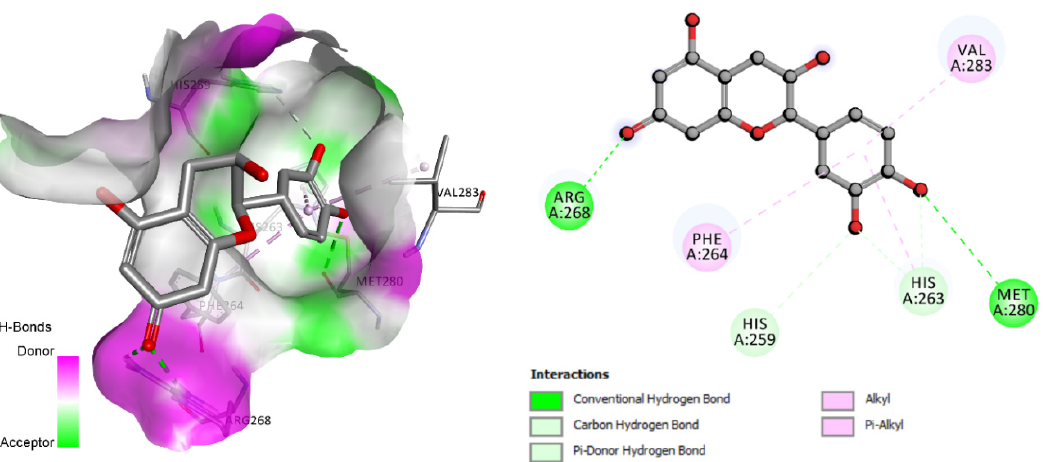
Figure 5. 3D and 2D protein–ligand interactions at the tyrosinase active site of the epicatechin (PDB CID: 2Y9X).